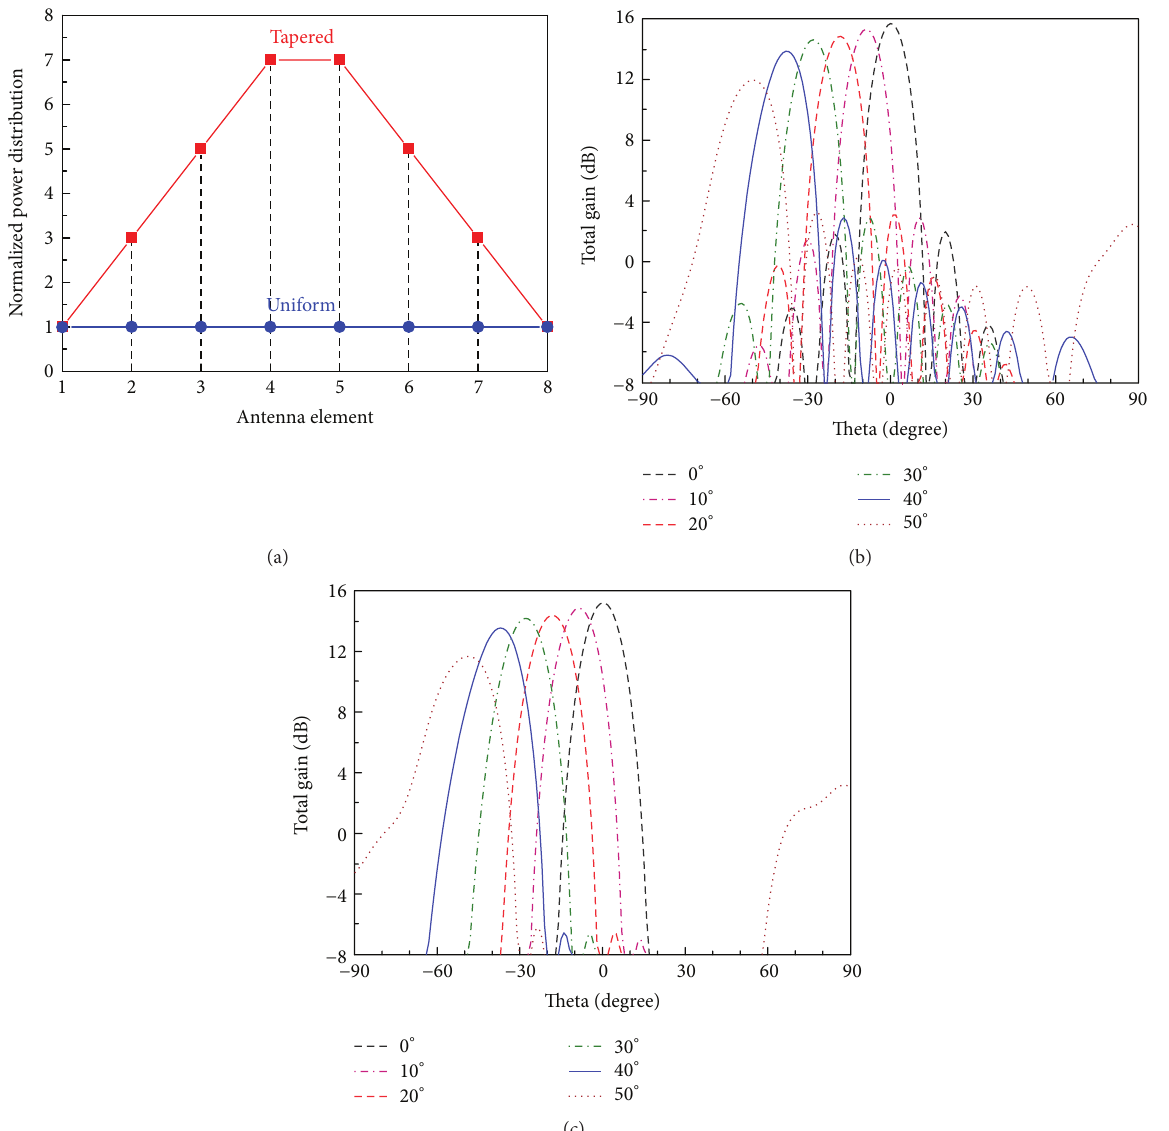
Figure 6: (a) Different power distributions for excitation of the eight-element linear array. Simulated scanning performance in 𝐸 -plane for the array at 28 GHz with (b) uniform and (c) tapered